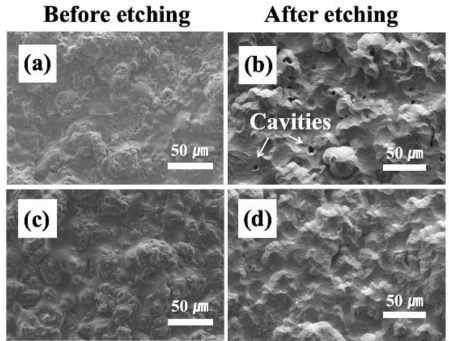
Figure 2. FE-SEM images of the surface of Y 2 O 3 and YO 0.6 F 2.1 coatings before and after exposure to